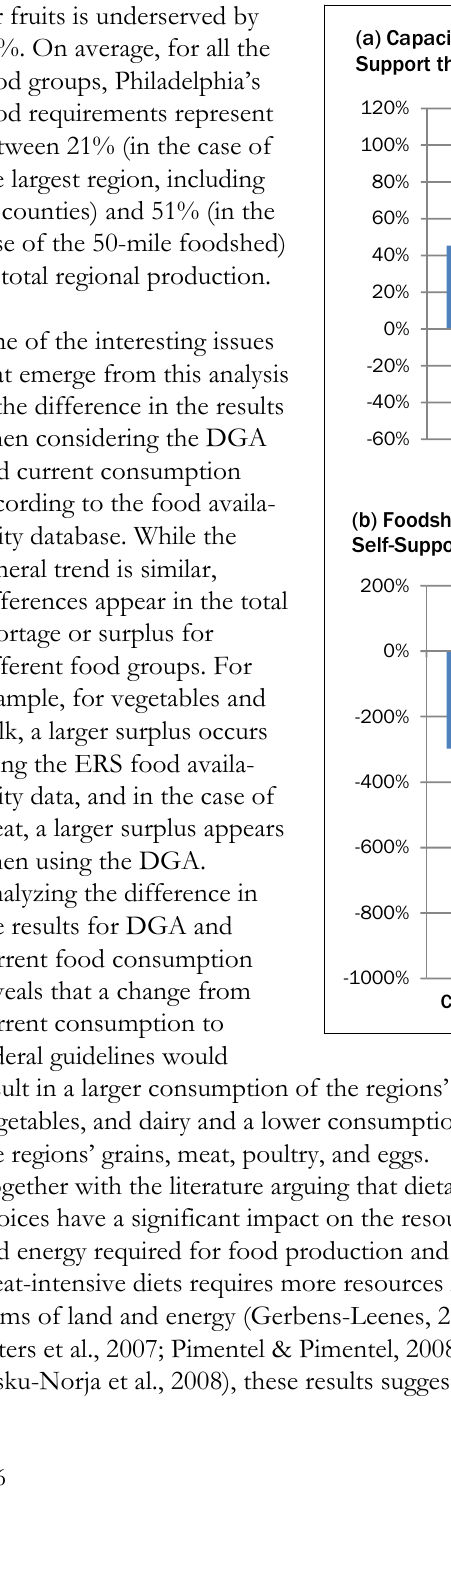
Figure 7. Capacity To Support Food Requirements Based on Current Food